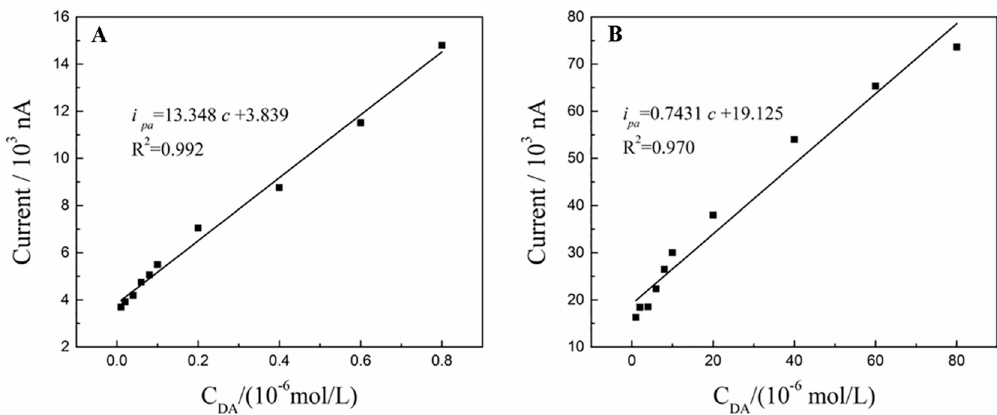
Figure 9. The linear relationship between the oxidation peak i pa and the concentration of DA in the range of 1 × 10 − 8 mol/L~1 × 10 − 6 mol/L ( A ) and 1 × 10 − 6 mol/L~8 × 10 − 5 mol/L ( B ).